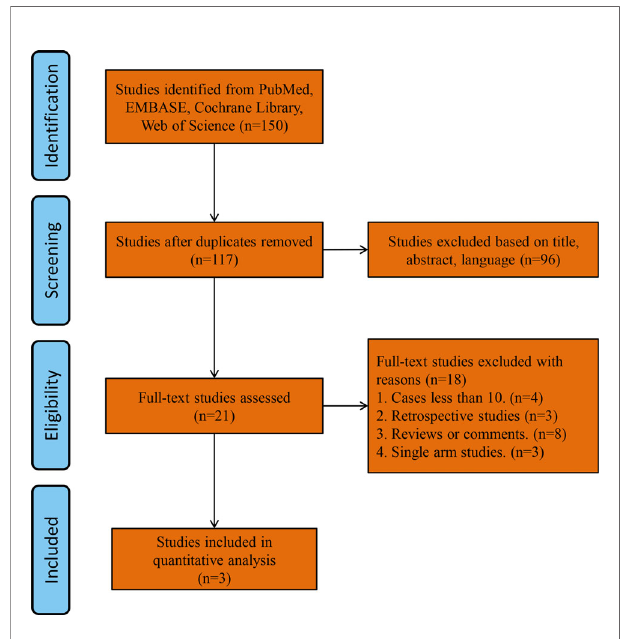
FIGURE 1 | Flow chart of this meta-analysis.